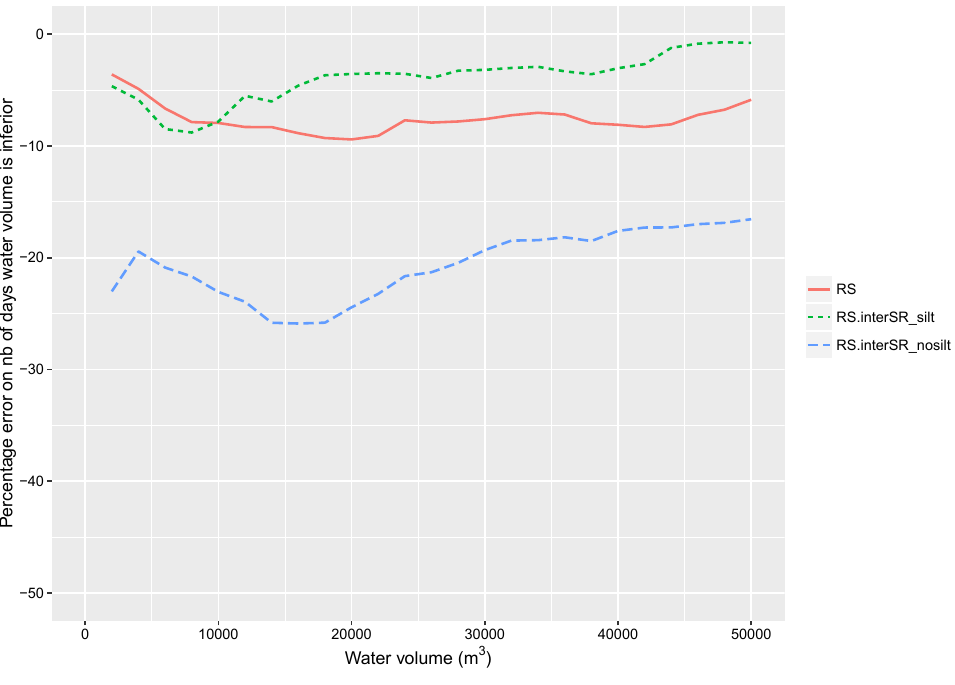
Figure 14. Error in the number of days water levels fall below a given volume for Gouazine